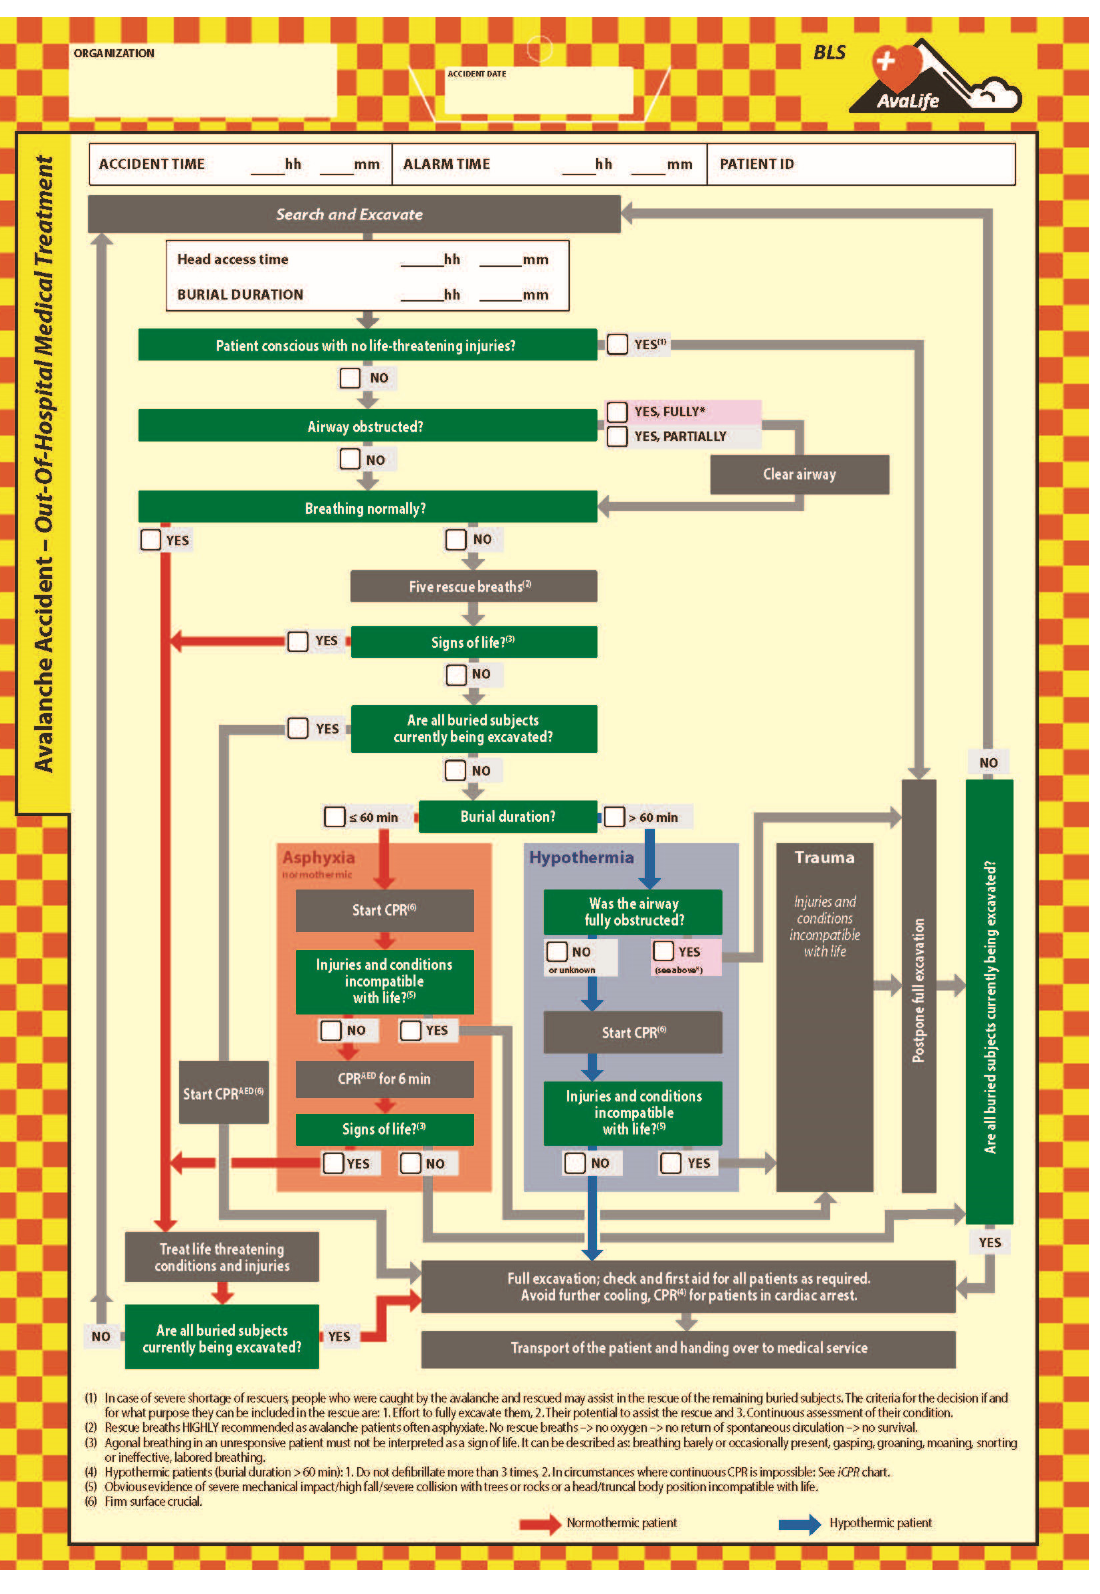
Figure 8. The Out-of-Hospital Medical Treatment module of AvaLife. In case of a shortage of resources, all rescuers, independently of if they are BLS or ALS qualified, have to follow the “Greatest good for the greatest number” paradigm in